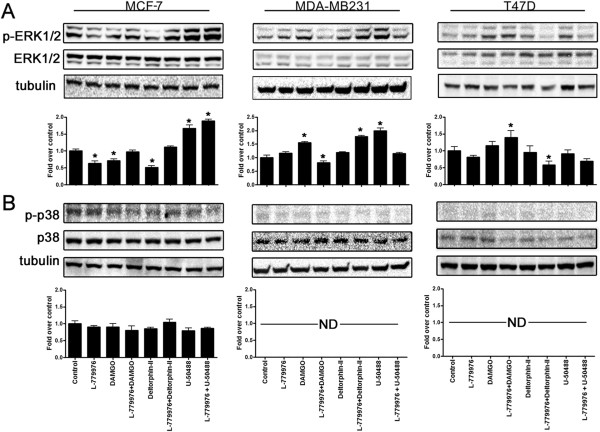
MAPKs (ERK1/2 and p38) are modulated in a receptor and cell-specific manner. Whole cell lysates obtained from MCF-7, MDA-MB231 and T47D cells following treatment with SSTR2 and ORs agonists alone and/or in combination were subjected to western blot analysis and probed for phospho-and total ERK1/2 and p38 (1:1000). (A) Immunoblots illustrating agonist mediated changes in phosphorylated ERK1/2 in cell-specific manner. (B) Immunoblots displaying changes in the phosphorylation of p38 upon specific agonist treatments in breast cancer cells. SSTR2 and ORs activation inhibited p38 phosphorylation upon indicated treatment. Histograms depict changes in the expression levels of ERK1/2 using densitometric analysis. The data presented here is a representation mean ± SEM of three independent experiments. Significant difference was considered at *p < 0.05 vs. control.